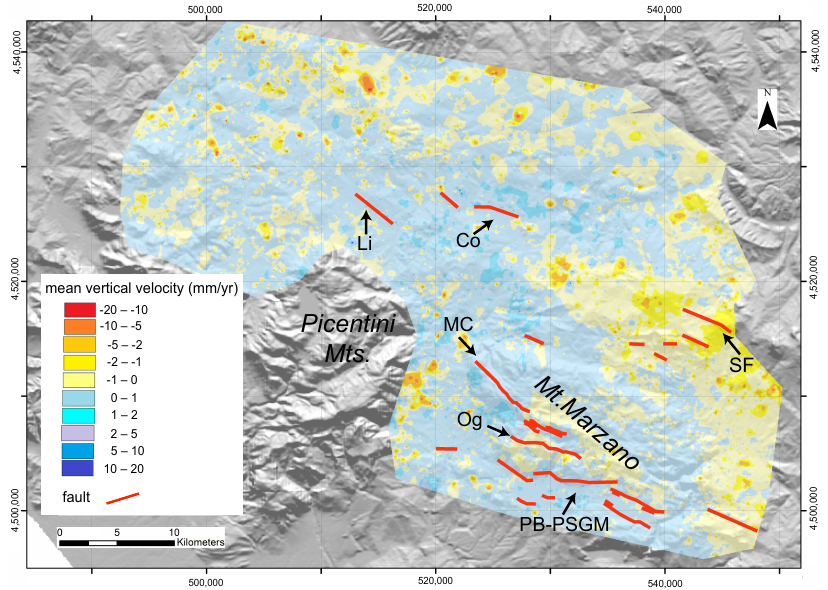
Figure 8. IDW interpolation (cell size 50 × 50 m) of ERS PS ‘native’ datasets (i.e., the datasets that include both normal and outlier PSs), showing the vertical mean velocity / ground deformation in the 1992–2000 timespan. Fault / fault array labelling as in Figure